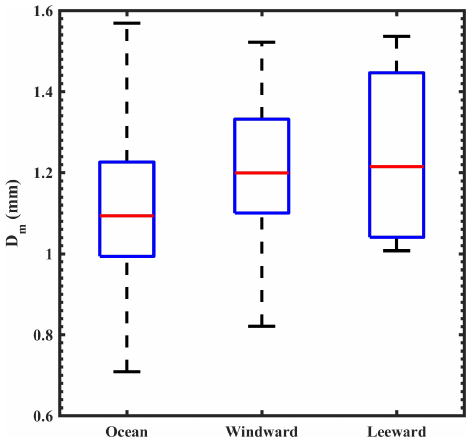
Figure 4. Box-and-whisker plot of D m distributions over the ocean, windward side (HACPL), and leeward side of the mountain from GPM measurements. The box represents the data between the first and third quartiles, and the whiskers show the data from the 12.5 and 87.5 percentiles. The horizontal line within the box represents the median value of the